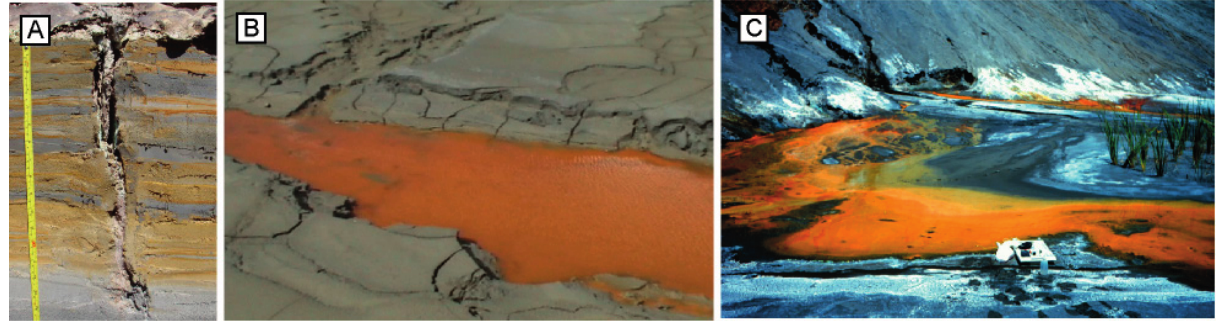
Figure 3. ( A ) Oxidation zone in the Talabre tailings impoundment after five years of oxidation (pH 3.9). Clearly visible the precipitation of Fe(III) hydroxides and the oxidation front [1]. ( B ) Precipitation of ferrihydrite in an active tailings impoundment due to the exposure of Fe(II)-rich waters to the atmosphere (Ocroyoc, Cerro de Pasco, Peru) [14]. And ( C ) outcrop of AMD (pH 3.15) at the foot of an active tailings dam with